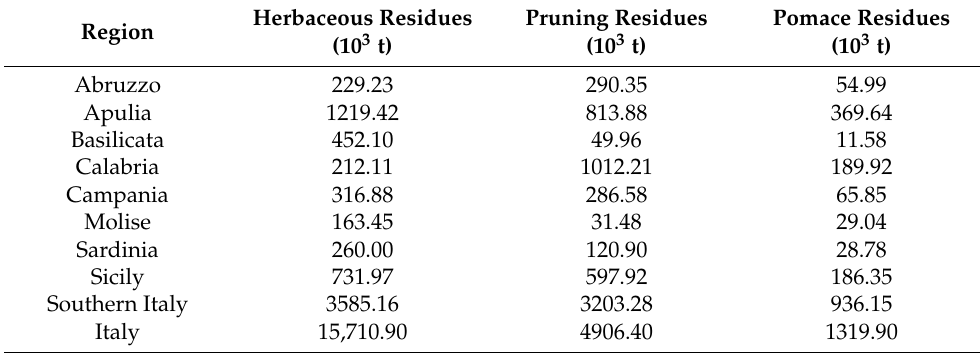
Table 8. Production of agricultural residues in Southern Italy, 2009 data [33] (adapted from ENEA,